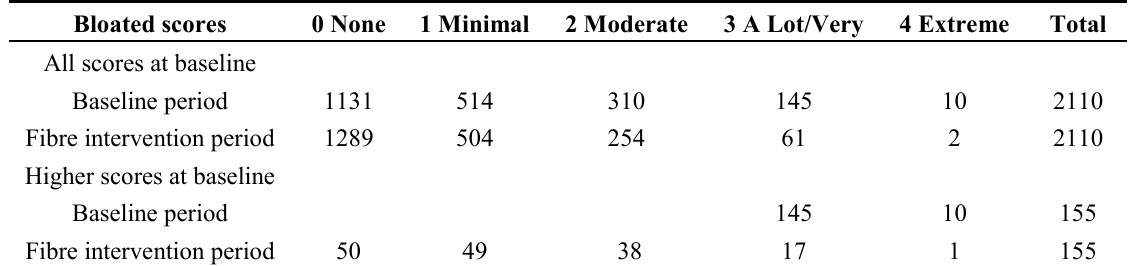
Table 5. Frequency of days of reporting of each level of the Likert scale scores for the digestive feeling “bloated” during each 14 day period, for participants with complete data at both time points. Frequencies are shown for participants with any “bloated” score at baseline (all scores) and for participants with higher scores (≥3) at baseline (extreme scores). Bloated scores 0 None 1 Minimal 2 Moderate 3 A Lot/Very 4 Extreme Total All scores at baseline